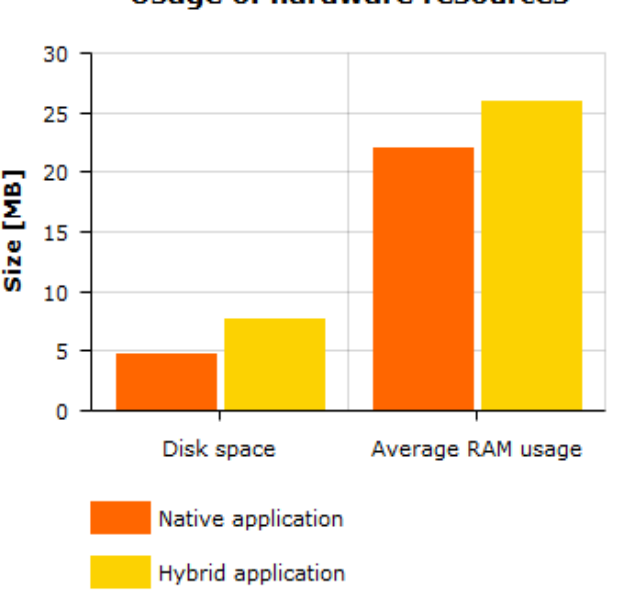
Figure 4. Usage of hardware resources.